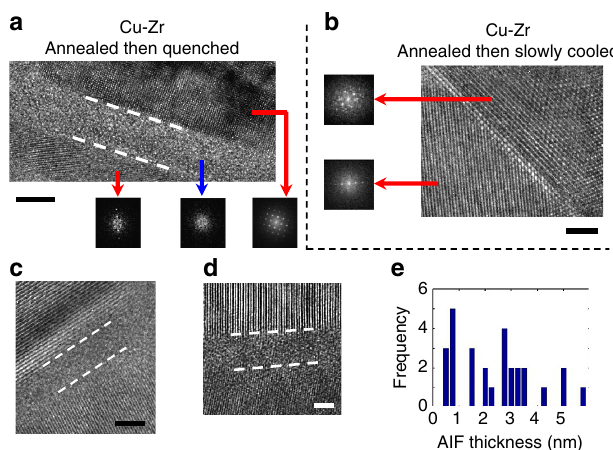
Figure 2 | High-resolution TEM images of grain boundary structure in nanocrystalline Cu-Zr alloys. ( a ) An amorphous intergranular film with thickness of 5.7nm was observed at a grain boundary after quickly quenching from 950 (cid:2) C (scale bar, 5nm). ( b ) In contrast, grain boundaries in a slowly cooled sample, with structures that are in equilibrium near ambient temperatures, are all ordered interfaces (scale bar, 2nm). Insets are fast Fourier transform patterns, highlighting the disordered nature of the interface in a . ( c , d ) Additional examples of amorphous complexions in the quenched sample (scale bars, 2nm), whereas e summarizes the measurements from the 28 interfacial films found